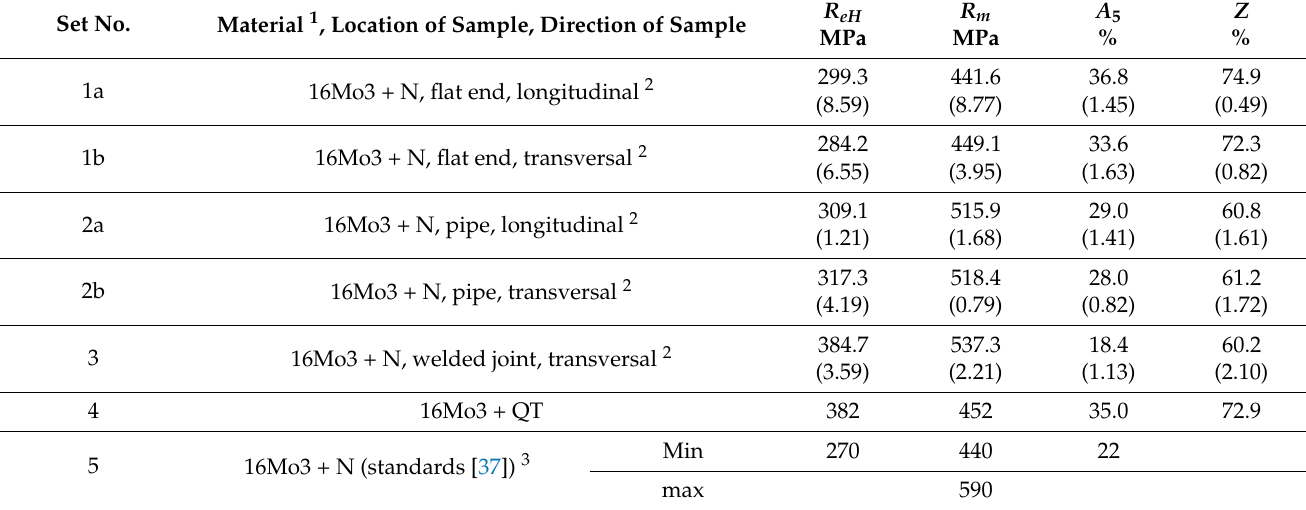
Table A2. Mechanical properties of chrome-molybdenum 16Mo3 alloy steel. Set no. Material 1 , Location of Sample, Direction of Sample